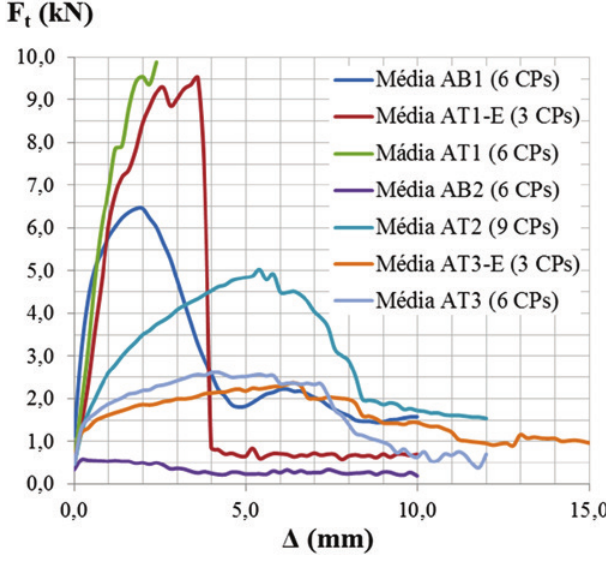
Figura 13 Diagramas F